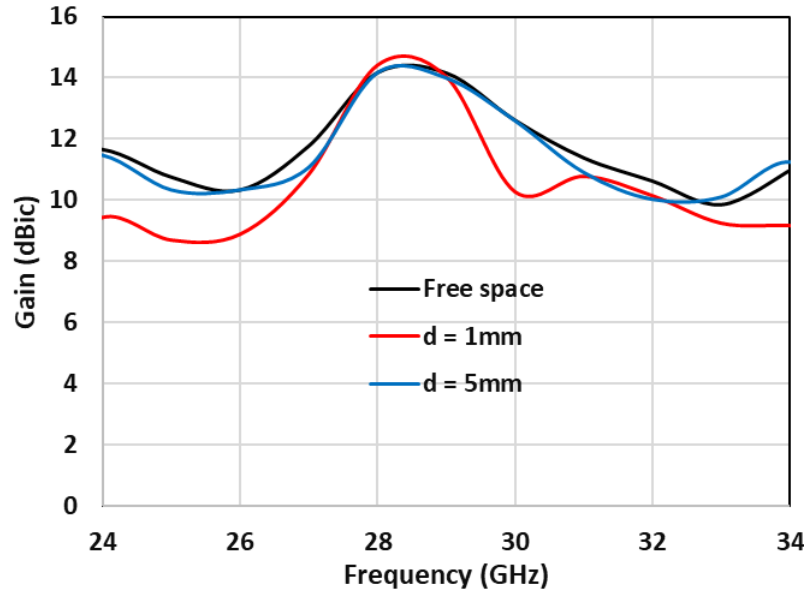
Figure 13. Gain of a DRA array operating in free space and next to a body phantom.